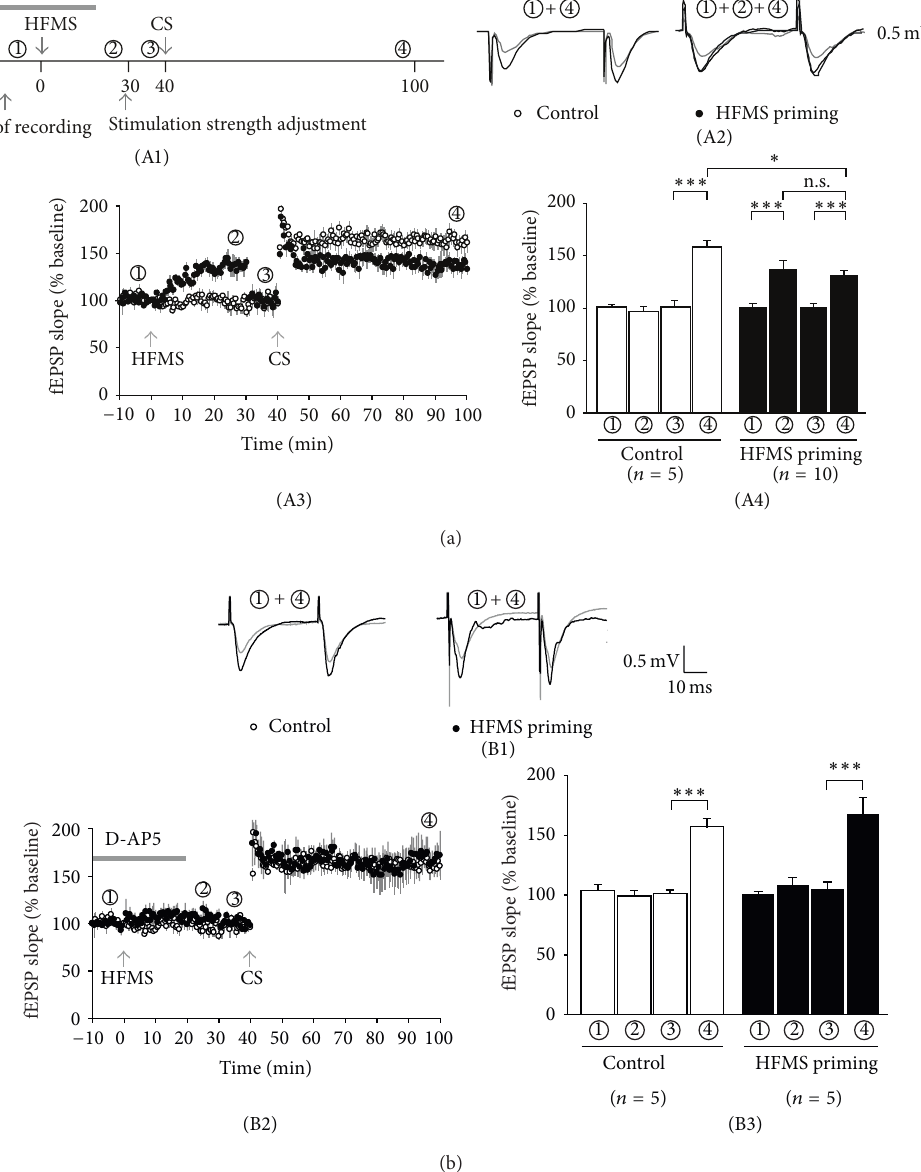
Figure 3: LTP reduction caused by HFMS priming is NMDA receptor-dependent. (A1) Experimental paradigm showing the timepoints of high-frequency magnetic stimulation (HFMS) and conditioning stimulation (CS). Application of the NMDA receptor blocker D-AP5 is indicated by the gray bar. (A2) Sample traces of timepoints A , B , and D in naive (control) and HFMS-primed slices. (A3) Time course of CS-induced plasticity with (closed circles) or without (open circles) priming. HFMS priming was applied following baseline recording. The enhanced fEPSPs by HFMS priming were readjusted to baseline level before electrical stimulation (CS). HFMS caused a significant reduction of CS-induced LTP. (A4) Average fEPSP slopes calculated during 26–30 and 96–100 min after HFMS application. Significant LTP was induced after CS in control slices without priming stimulation (open bar). In contrast, the level of CS-induced LTP in HFMS-primed slices was significantly reduced compared to slices without priming stimulation. Note that HFMS-induced potentiation and CS-induced potentiation were not significantly different. (B1) Sample traces of timepoints A and D in naive (control) and HFMS-primed slices under NMDA receptor-blocking conditions. (B2) Time course of CS-induced plasticity with (closed circles) or without (open circles) priming. HFMS priming was applied in the presence of the NMDA receptor antagonist D-AP5 (50 𝜇 M). The slightly enhanced fEPSPs following HFMS priming were readjusted to baseline level before electrical CS. D-AP5 was washed out after HFMS in order to allow NMDA receptor- dependent CS-induced LTP. (B3) Average fEPSP slopes calculated during 26–30 and 96–100 min after HFMS application. In contrast to panel (A4), the levels of CS-induced LTP were no longer different between HFMS-primed or unprimed